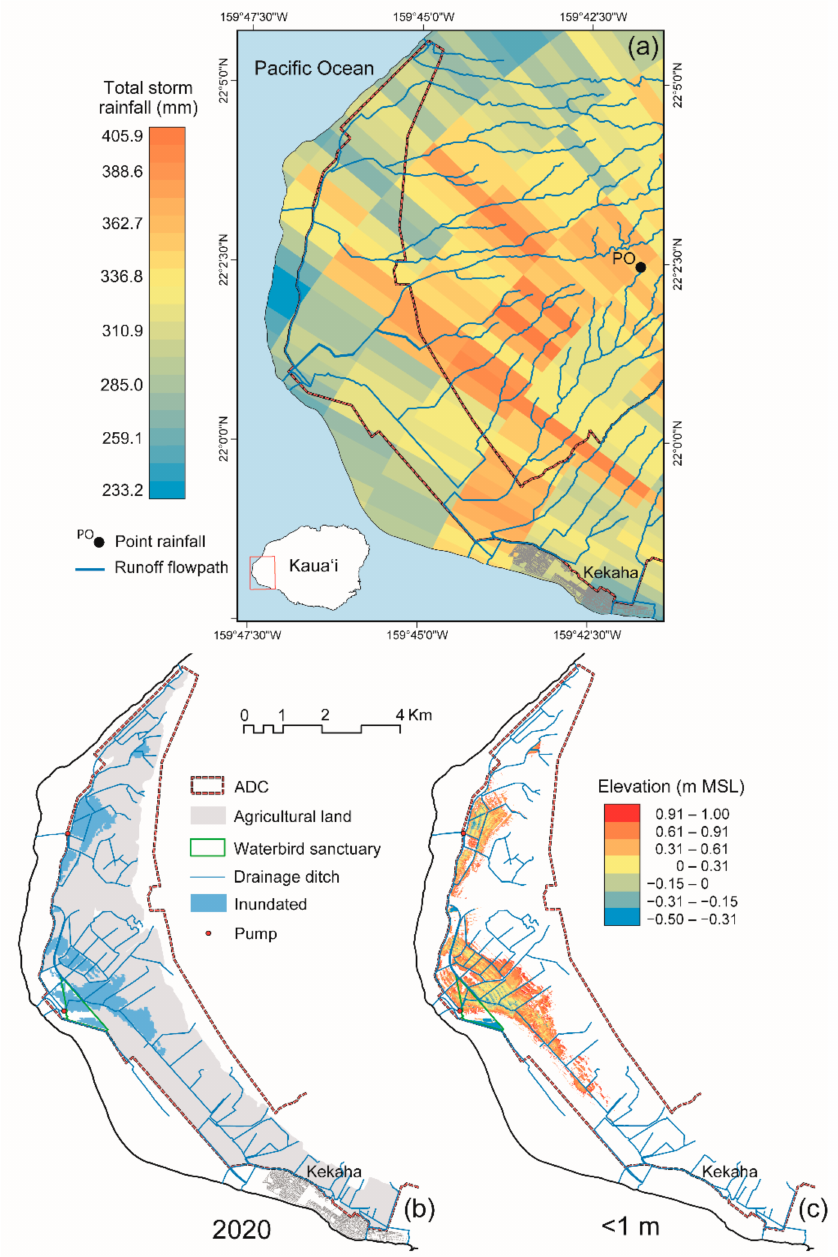
Figure 4. ( a ) South Kaua‘i (HKI), NEXRAD Level-III total storm rainfall 16–17 March 2020, runoff flowpaths, and location of the Pu ‘ u ‘ ¯Opae rain gauge; PO. ( b ) Extent of inundation following